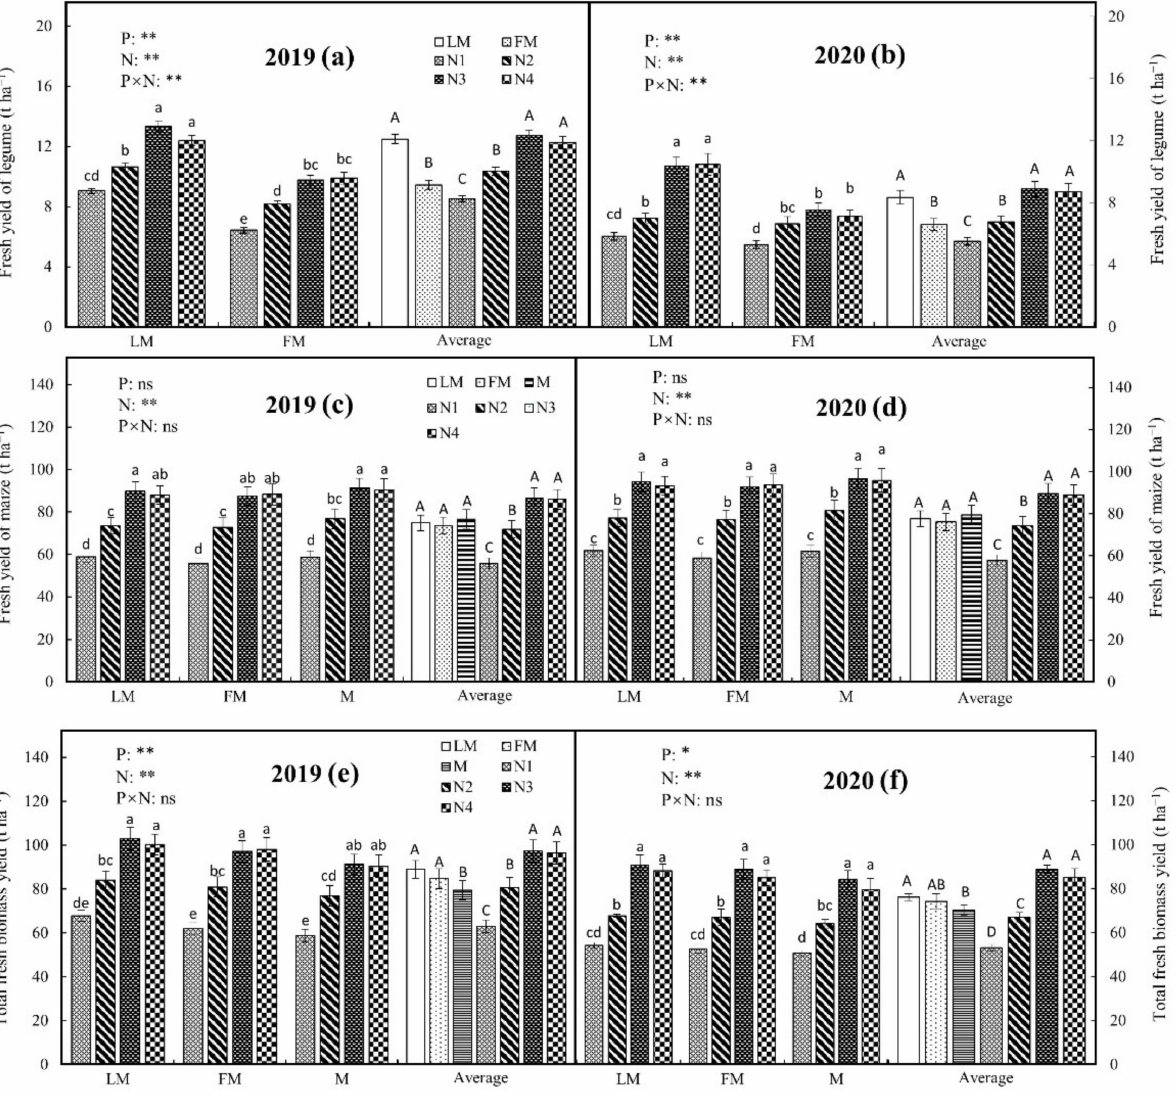
Figure 3. Fresh yield of legume, maize, and intercropping systems under different treatments in 2019 and 2020. Note: ( a ), fresh yield of legume in 2019; ( b ), fresh yield of legume in 2020; ( c ), fresh yield of maize in 2019; ( d ), fresh yield of maize in 2020; ( e ), total fresh biomass yield in 2019; ( f ), total fresh biomass yield in 2020. M, silage maize monoculture; FM, intercropping of fodder soybean and silage maize; LM, intercropping of Dolichos lablab and silage maize; N1, 0 kg ha − 1 N; N2, 120 kg ha − 1 N; N3, 240 kg ha − 1 N; N4, 360 kg ha − 1 N. P, N, and P × N represent planting patterns, N application, and interaction between them, respectively; * p < 0.05 level, ** p < 0.01; ns, no significant difference. Different lowercase letters in the same series indicate significant differences among different treatments for the same forage ( p < 0.05). The different uppercase letters in the same series indicate significant differences among different levels of factors for the same forage ( p <